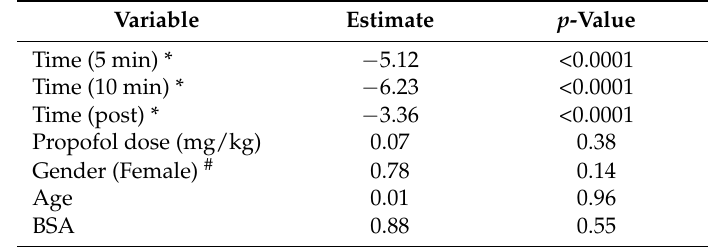
Table 2. Regression model predicting differential between core temperature and mobile thermal imager. Variable Estimate